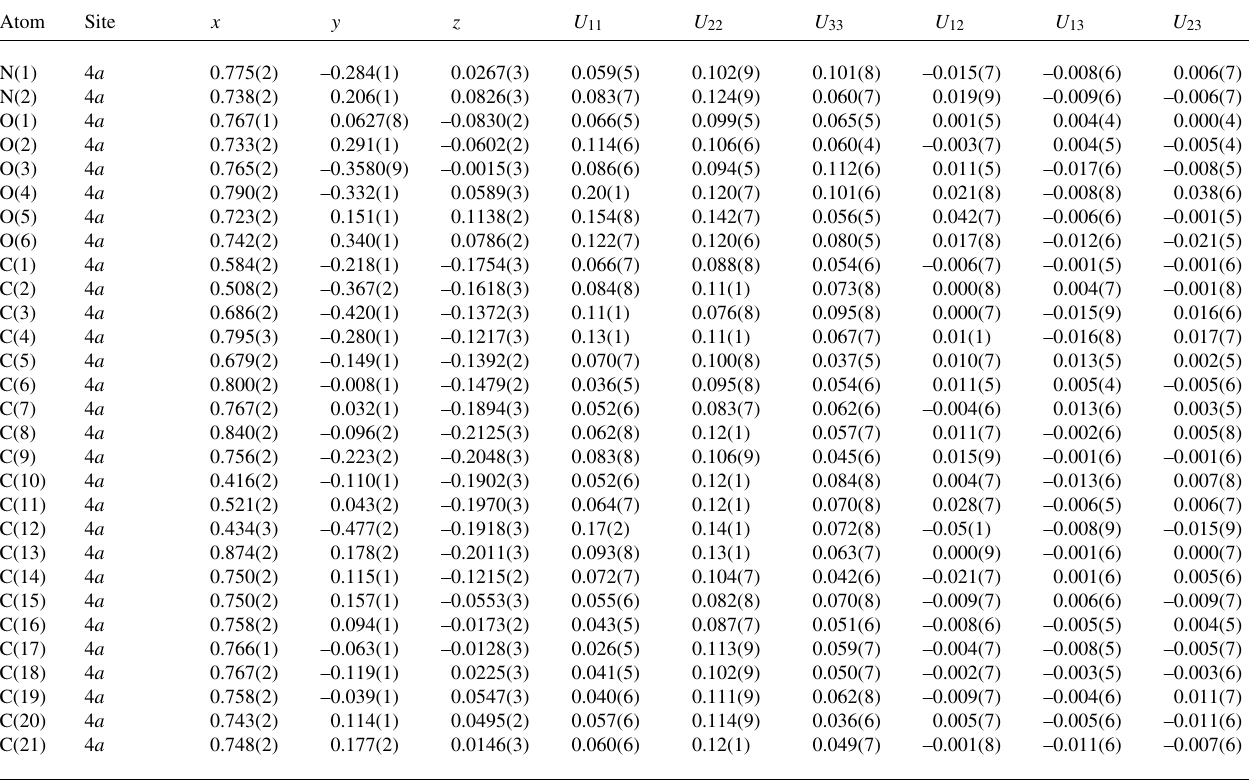
Table 3. Atomic coordinates and displacement parameters (in Å 2 ) .